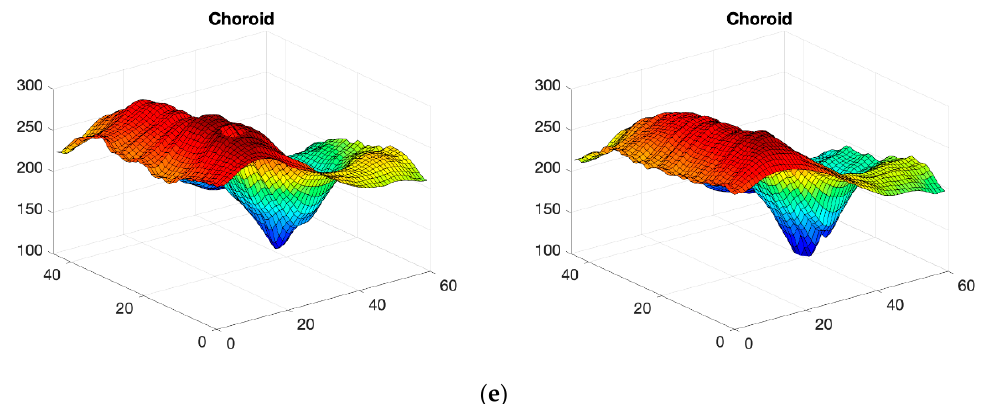
Figure 2. 3D images of the 5 structures obtained with OCT in real subjects; mean value in all control subjects (left) and mean value in MS patients (right). ( a ) complete retina; ( b ) RNFL; ( c ) GCL+; ( d ) GCL++; ( e ) choroid.